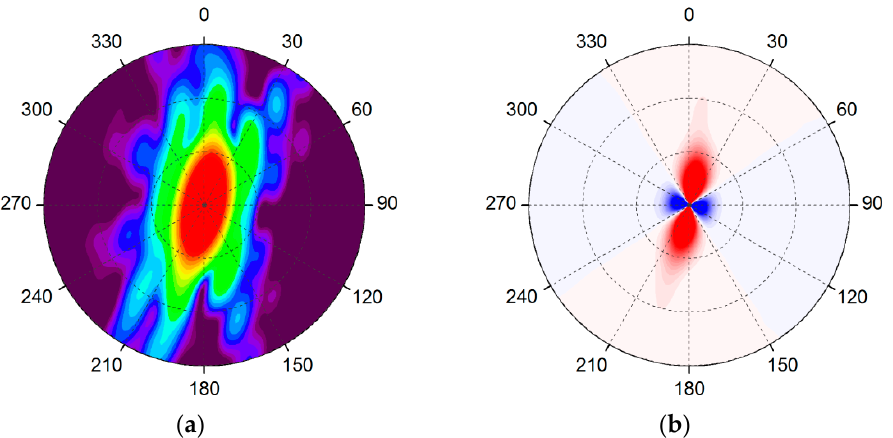
Figure 9. Backscattered intensity M 11 ( n ) ( a ) and polarization element − M 12 ( n ) ( b ) for two beams of Figure 7 at incoherent summation. The figure centers are the exact backward direction θ = 180 ◦ , the blue color in ( b ) corresponds to negative quantities.